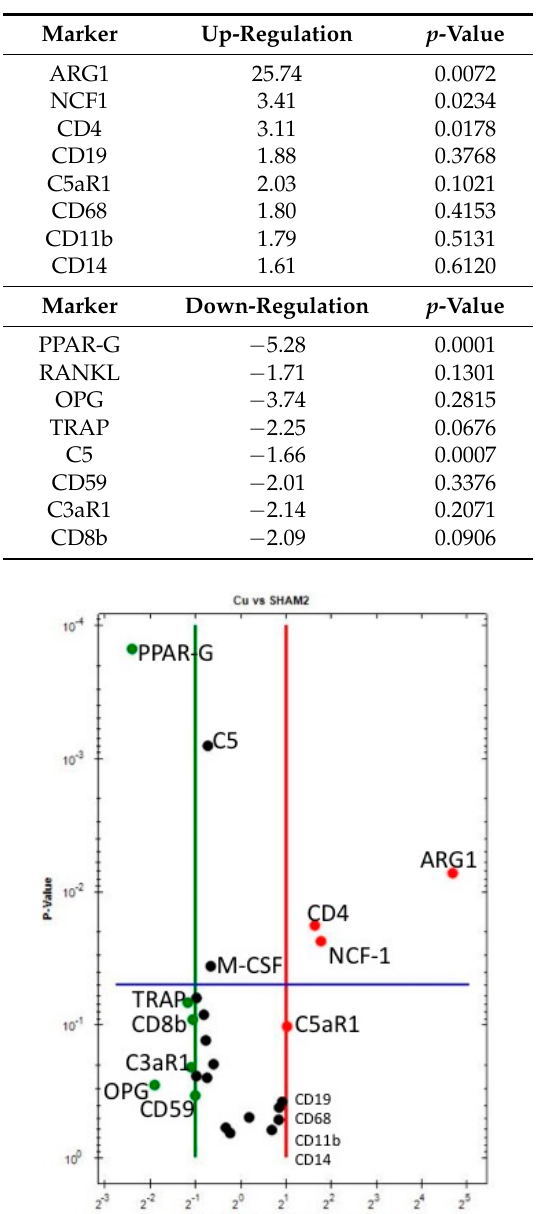
Table 5. Gene expression Cu vs. Sham.